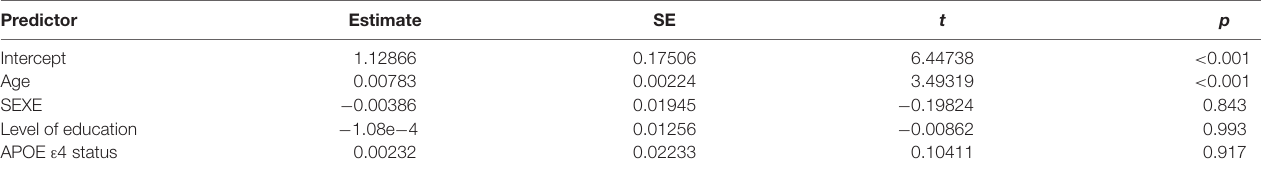
TABLE 2 | Linear regression model including WM-MD change over-time as a dependent variable and age, sex, level of education and ApoE4 status as explicative variables.